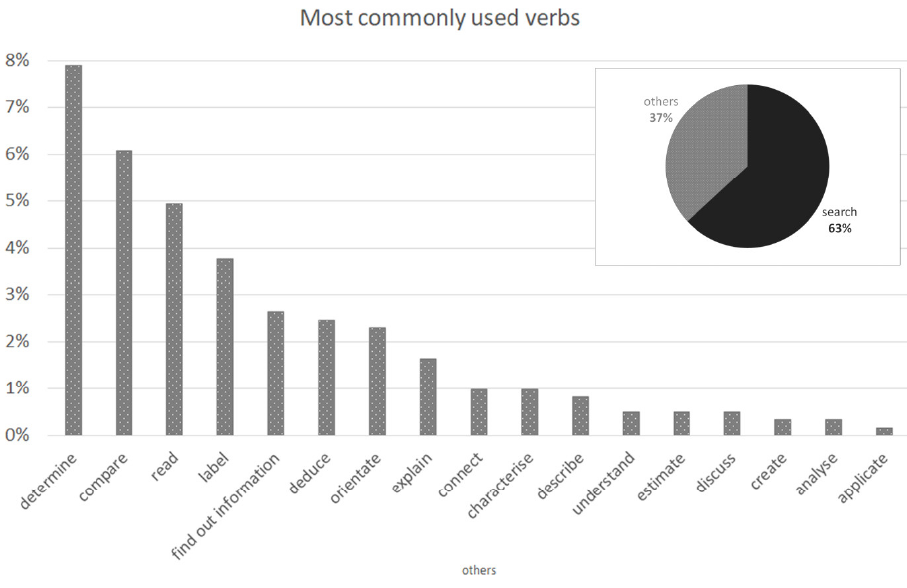
Figure 7. The most frequently used verbs in the description of tasks with an atlas (Q6). The used verbs are related to Bloom’s taxonomy of educational objectives